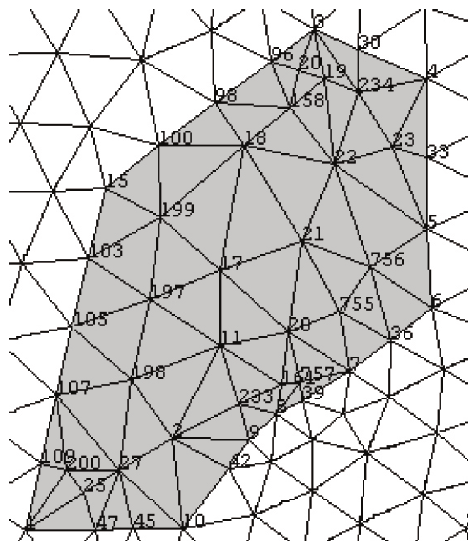
Fig. 4. The stress field of the Baltic region defined from GPS